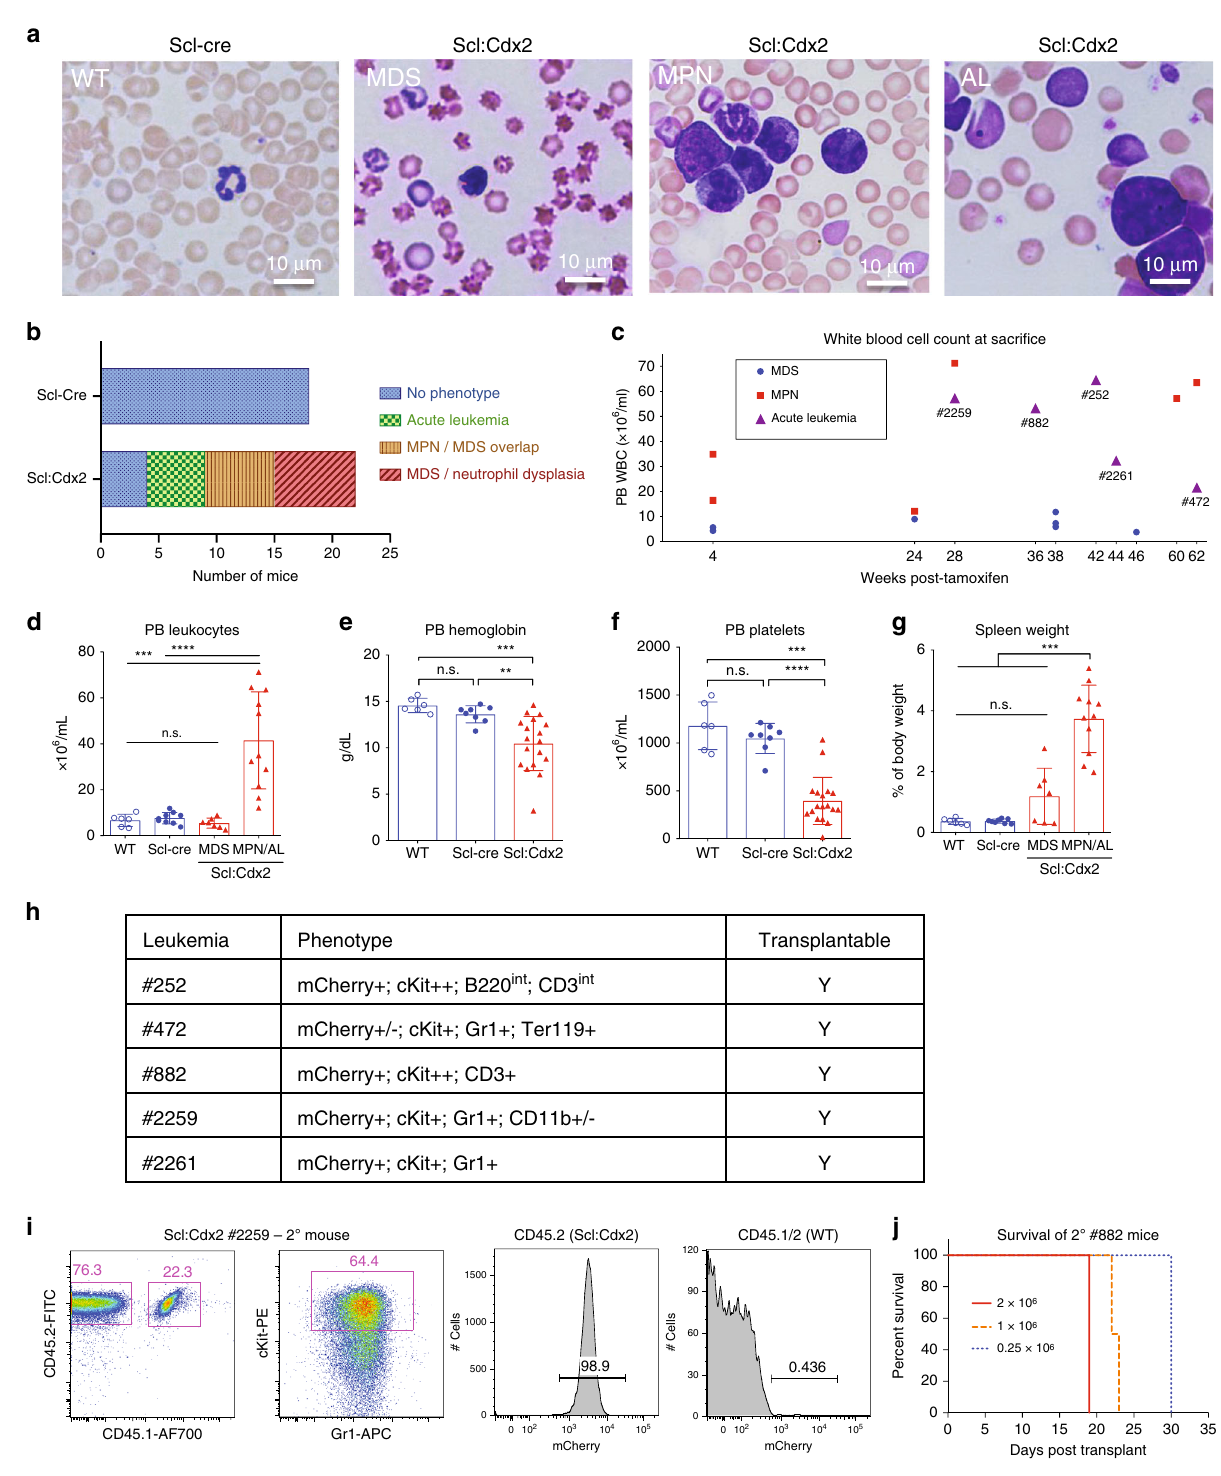
Fig. 2 Cdx2 expression in HSPC results in lethal and transplantable disease. a Representative Wright-Giemsa stained PB smears showing distinct phenotypes of Scl -Cre (normal) and Scl:Cdx2 mice at disease onset. Scale bars on bottom right of each image indicate 10 µ m. MDS, myelodysplastic syndrome; MPN, myeloproliferative neoplasm; AL, acute leukemia. b Incidence of hematological disease in Scl -Cre ( n = 18) and Scl:Cdx2 ( n = 22) mice after 60 weeks of monitoring. ( c ) White blood cell (WBC) counts of Scl:Cdx2 mice ( n = 18) at date of sacri fi ce and assignment of disease diagnosis. The identi fi cation numbers of mice with acute leukemia are indicated. d Leukocyte counts (WBC), ( e ) hemoglobin, f platelet counts, and g spleen size relative to body mass of mice at sacri fi ce. (WT n = 6; Scl -cre n = 8; Scl:Cdx = 18 [MDS n = 7; MPN/AL n = 11]). h Table showing acute leukemia immunophenotype in mCherry + cKit + PB cells of Scl:Cdx2 mice at disease onset and transplantability status of these cells. i Representative fl ow cytometry of PB from mice transplanted with Scl:Cdx2 #2259 acute leukemia BM cells. j Survival curve of secondary leukemia mice transplanted with varying cell numbers of Scl:Cdx2 #882 BM cells ( n = 10). N = biologically independent animals. Statistical analyses performed using two-tailed Mann – Whitney test. Log-rank Mantel-Cox test used for survival curve. Data are plotted as mean values + / − SD. n.s.; not signi fi cant. * P < 0.05, ** P < 0.01, *** P < 0.001, **** P <